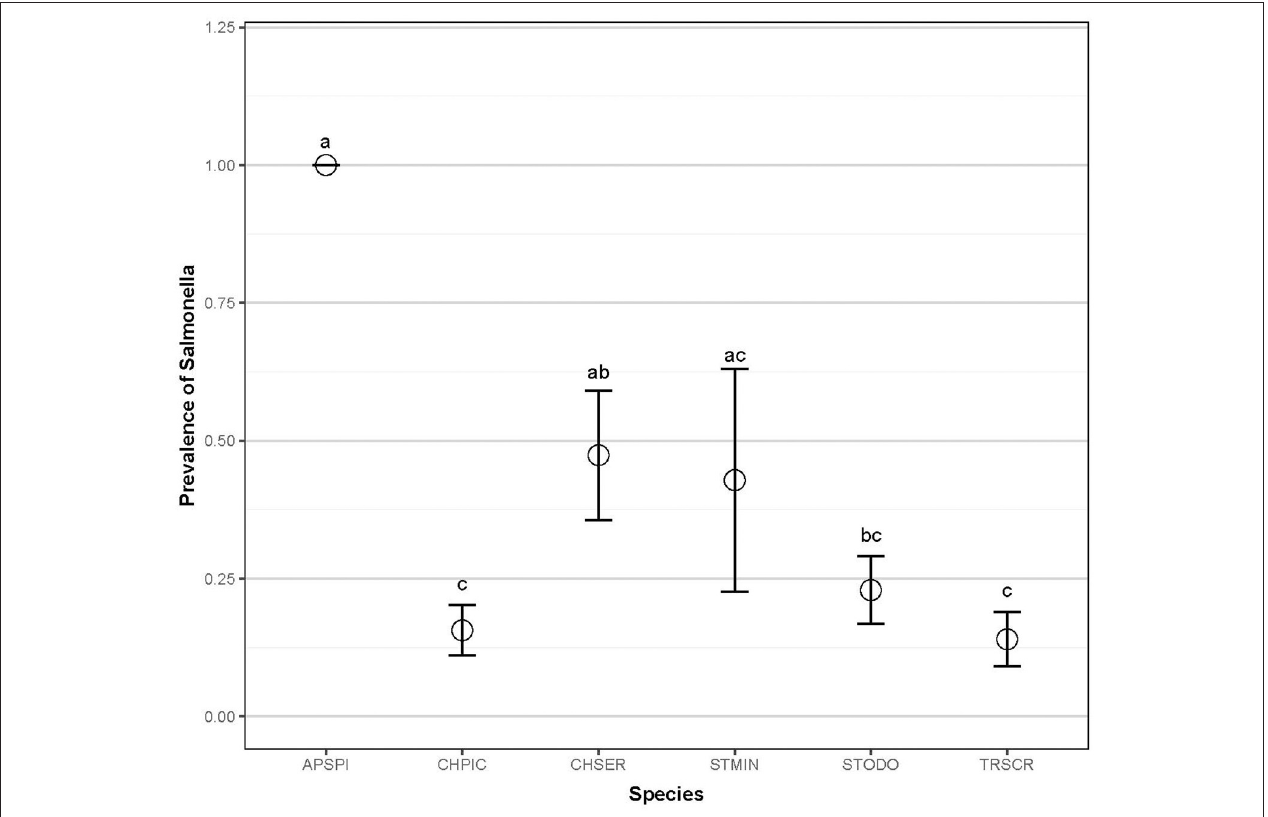
FIGURE 2 | Salmonella prevalence of six aquatic turtle species (2012–2013). Letters indicate statistical significance. Common snapping turtle, Chelydra serpentina (CHSER, n = 20); common musk turtle, Sternotherus odoratus (STODO, n = 48) ; Eastern painted turtle, Chrysemys picta (CHPIC, n = 65); yellow-bellied slider, Trachemys scripta scripta (TRSCR, n = 50); Spiny softshell turtle, Apalone spinifera (APSPI, n = 4); and loggerhead musk turtle, Sternotherus minor (STMIN, n =